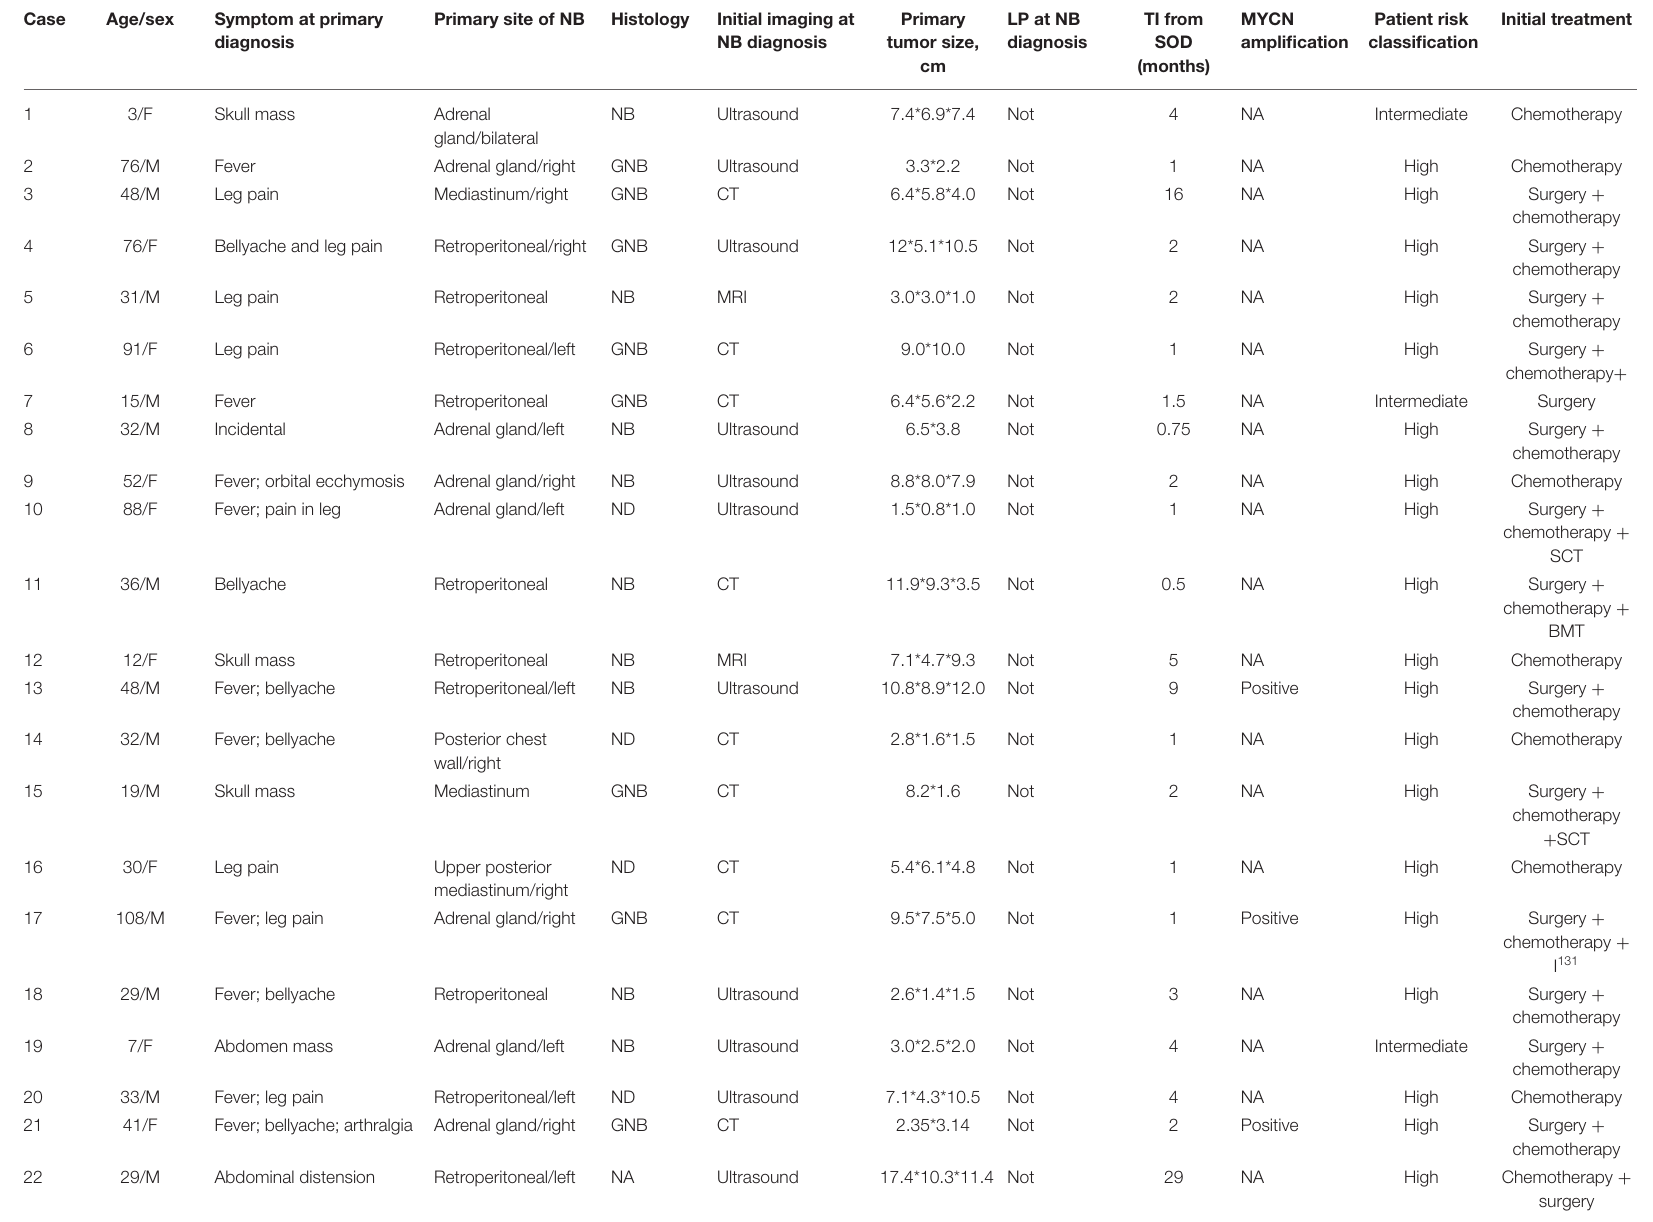
TABLE 2 | Summary of clinical characteristics of patients at the initial diagnosis of neuroblastoma in the IM